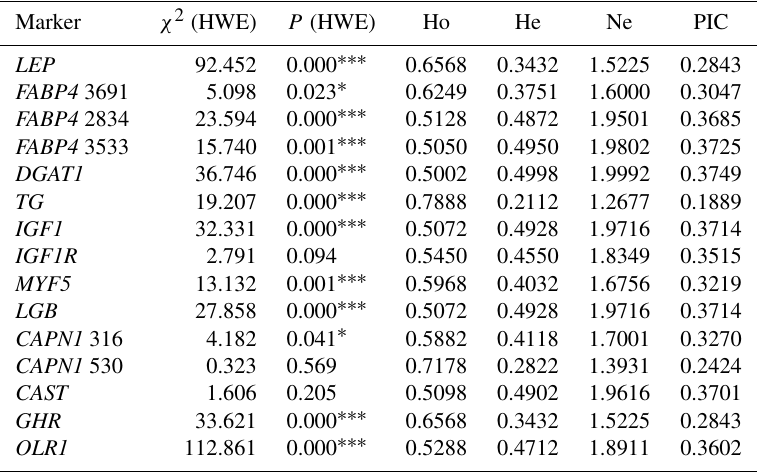
Table 3. Genetic diversity at the selected genes in the total sample of animals ( n = 296). Marker χ 2 (HWE) P (HWE) Ho He Ne